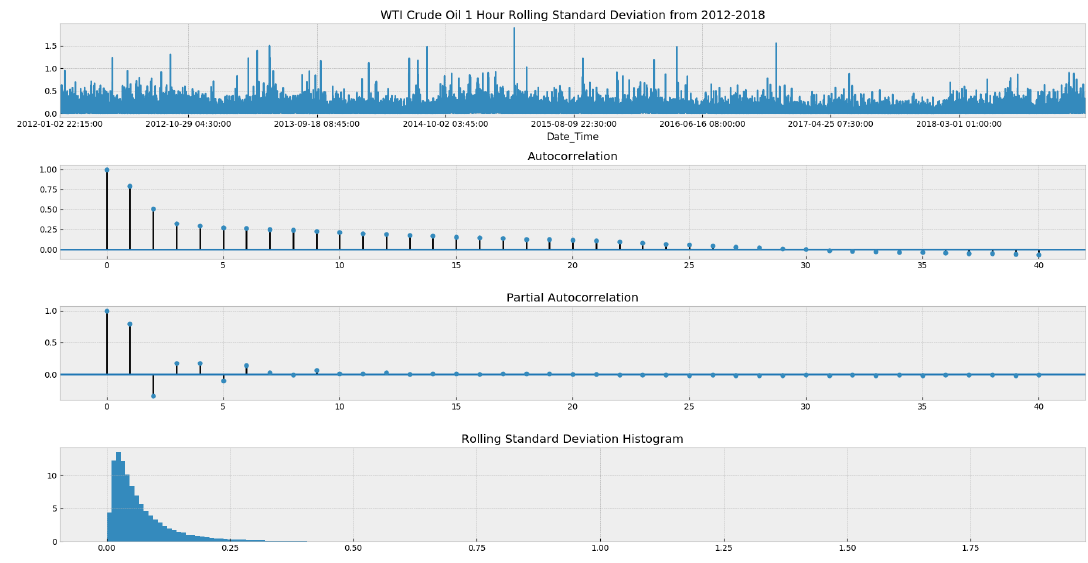
Figure 1: ACF/PACF-plot and Histogram-plot of WTI Light Crude Oil 1 hour window rolling standard deviation from (Jan. 2012 - Dec. 2018), original raw price